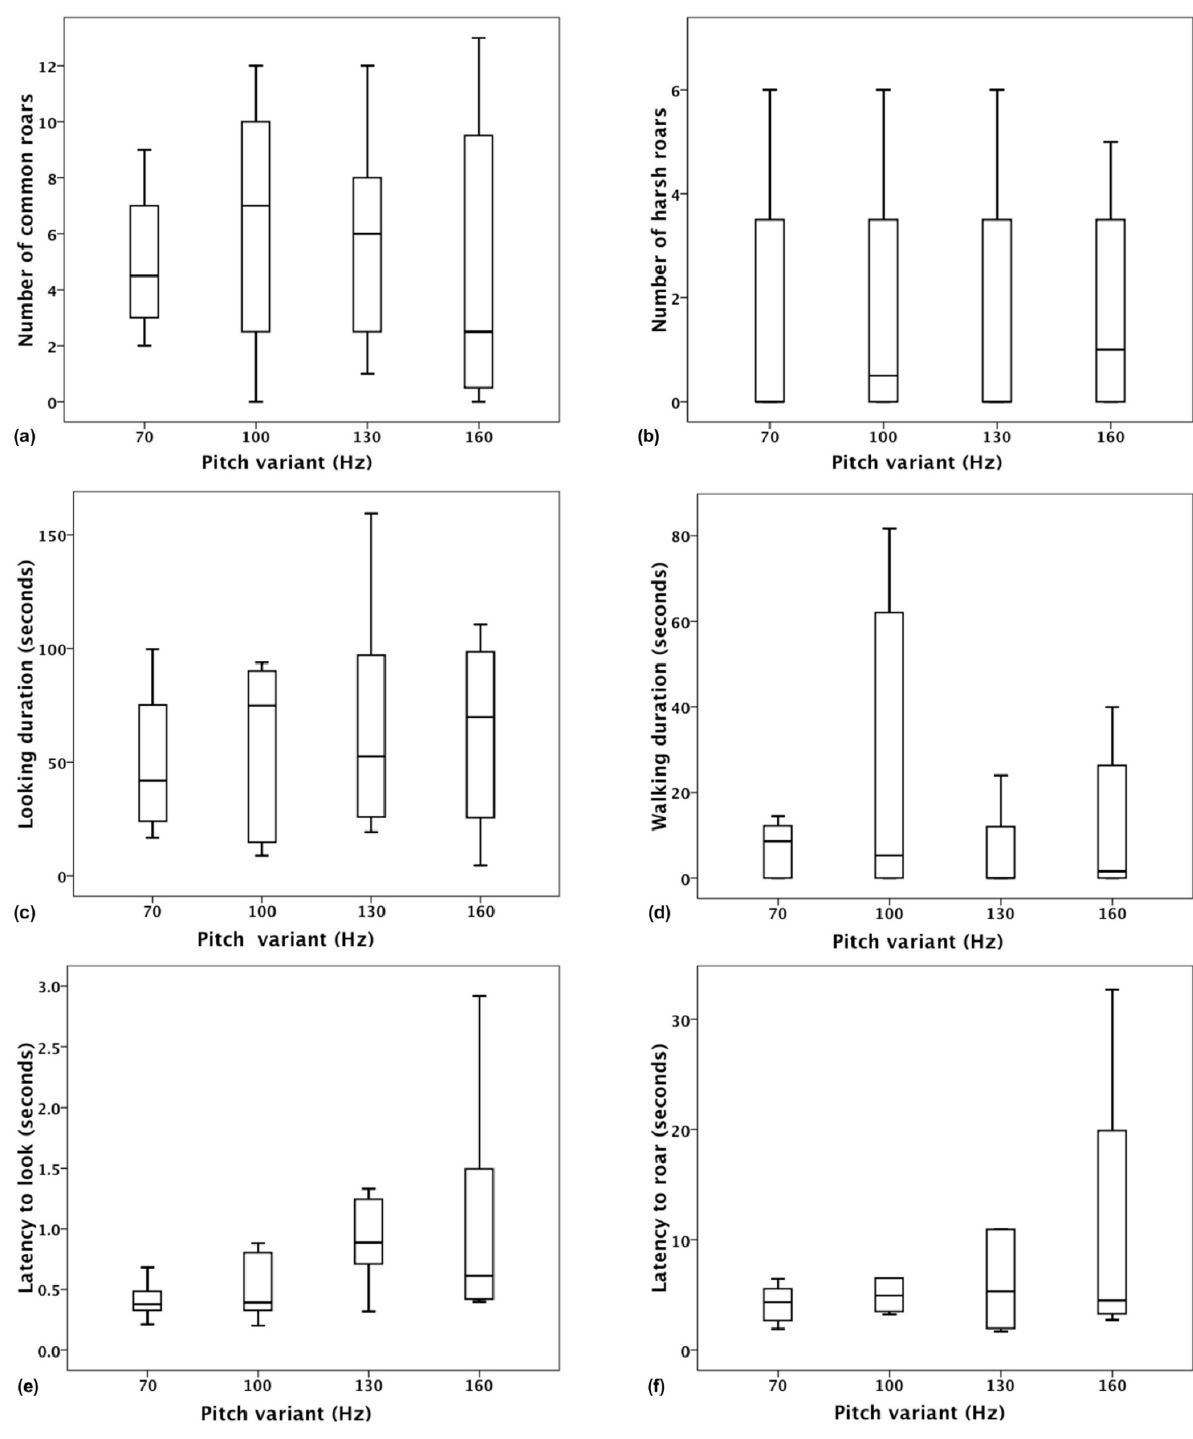
Figure 2. Behavioural responses of focal stags to playback experiments. Boxplots (with first, second (median), third quartiles, and range; outliers are not represented) illustrating the effect of F0 variant on the key behavioural variables characterizing the stag’s response to playbacks (Friedman test, p-values adjusted following Benjamini-Hochberg correction; N =8); number of common (A) and harsh (B) roars, time spent looking (C) and walking (D) towards the loudspeaker, latency to look at the speaker (E) and latency to roar back after stimulus presentation